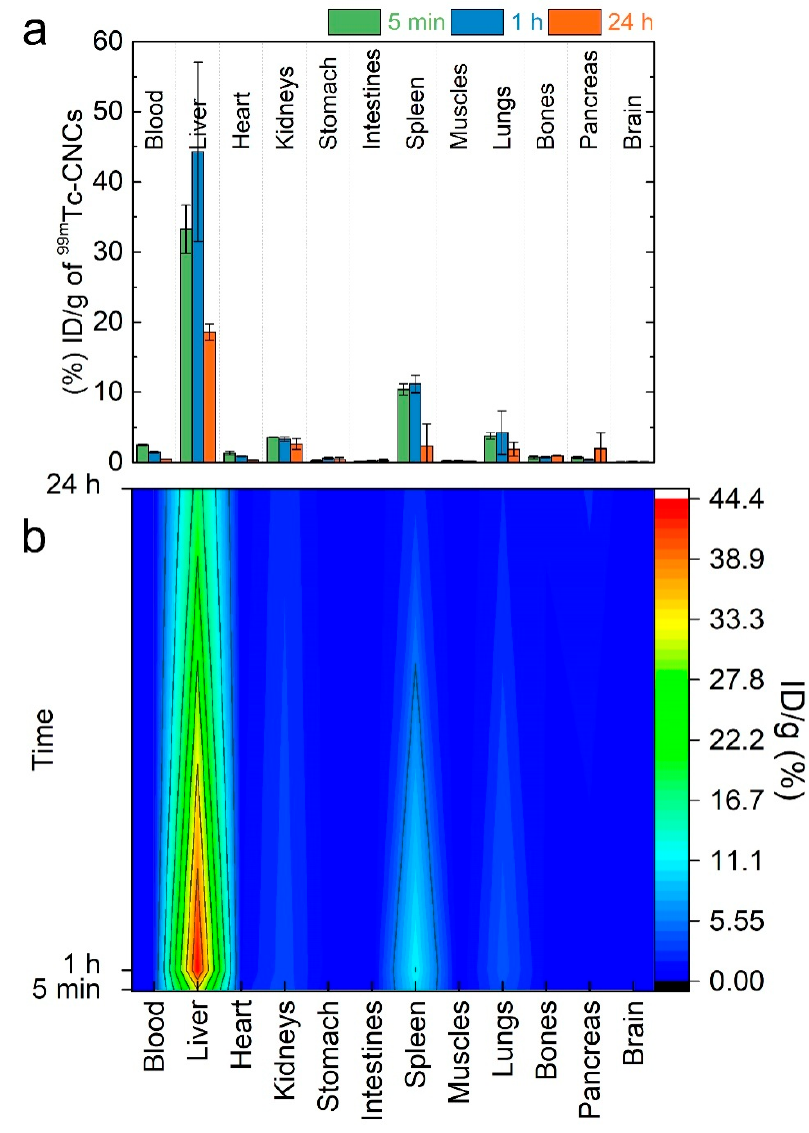
Figure 2. ( a ) Biodistribution data of Swiss-Webster mice intravenously injected with [ 99m Tc] Tc-colloidal nanoclusters (CNCs) (D TEM ~73 nm). The values are expressed as a percentage (%) of injected dose (ID) per gram (g), at 5 min, 1 h, and 24 h post-injection (p.i.) (means ± standard deviation; ( n = 2)); ( b ) Contour plot of ID/g (%) for the studied organs and the decrease of radioactivity over time.